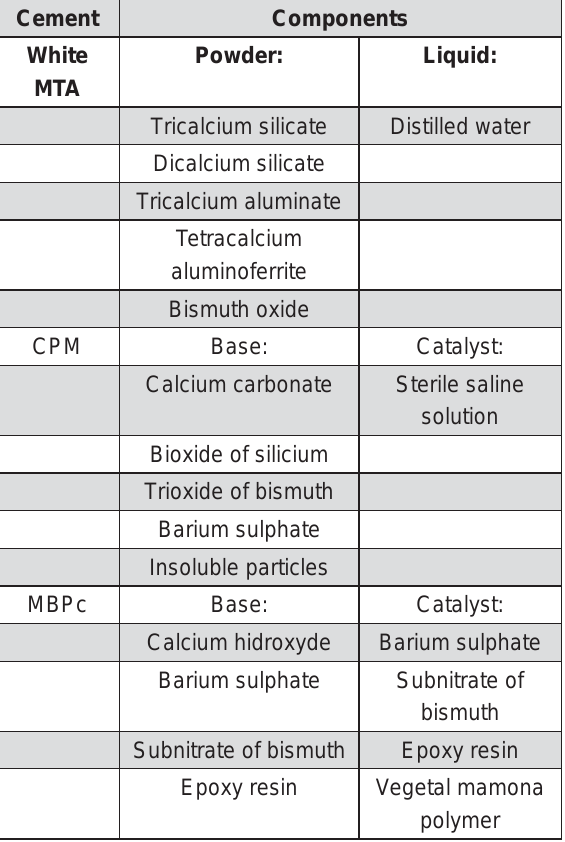
Figure 1- Composition of the evaluated